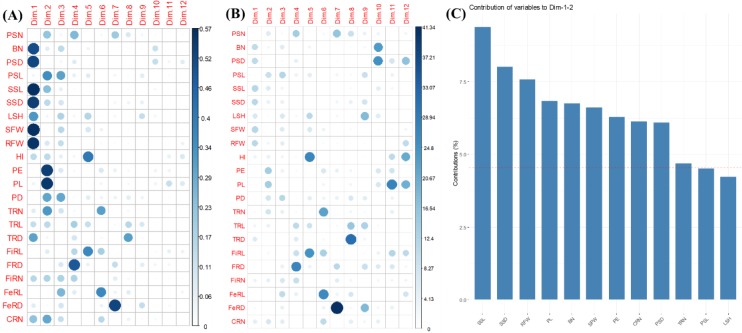
A: Plot of quality of representation of the variables (cos2 of variables) on the factor map for all dimensions, including the first seven dimensions considered significant following the PCA. Components with eigenvalues greater than one were considered significant in PCA. B: Plot showing the total contribution of variables in accounting for the variability in the principal components. C: Plot showing the total contribution of variables in accounting for the variability in PC1 and PC2. The red dashed line on the graph indicates the expected average contribution and variables with a contribution greater than this expected average could be considered as important.